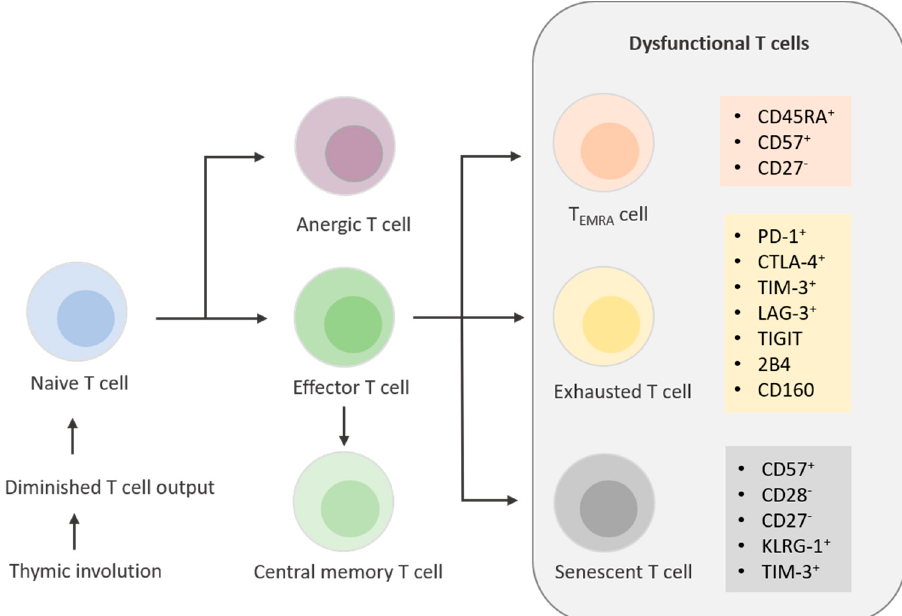
Figure 1. T cell differentiation and aging. Thymic involution leads to diminished T cell output in early adulthood. T cells further develop into anergic, effector, or central memory T cells. Over the course of immunological aging, T cells undergo drastic changes with different surface markers expressed on T EMRA cells, exhausted T cells, and senescent T cells.